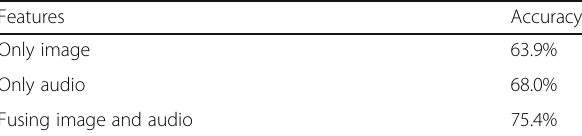
Table 2 Accuracy of different inputs Features